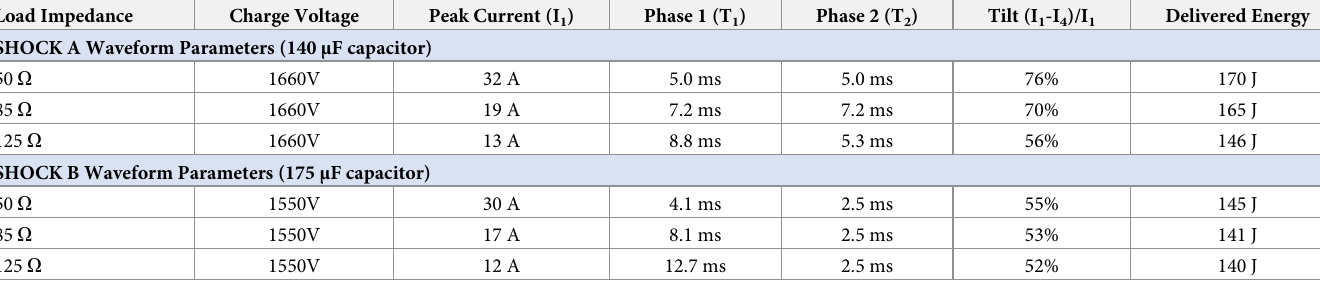
Table 1. SHOCK A and SHOCK B waveform